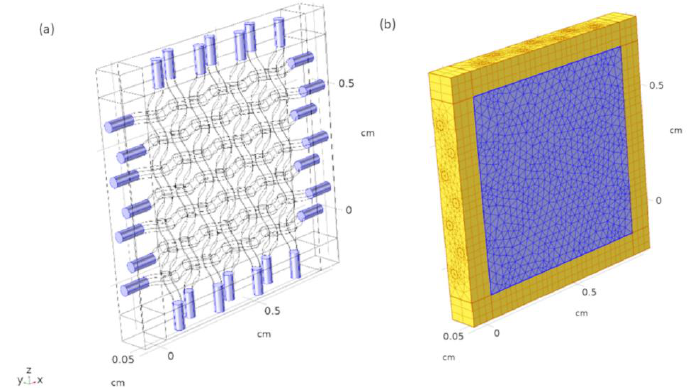
Figure 2. Outer domain wall of the fiber reinforced in geopolymer composite ( a ) and ( b ) mesh size of the composite. Table 1. Thermal conductivity properties of carbon fiber reinforced geopolymer composite.